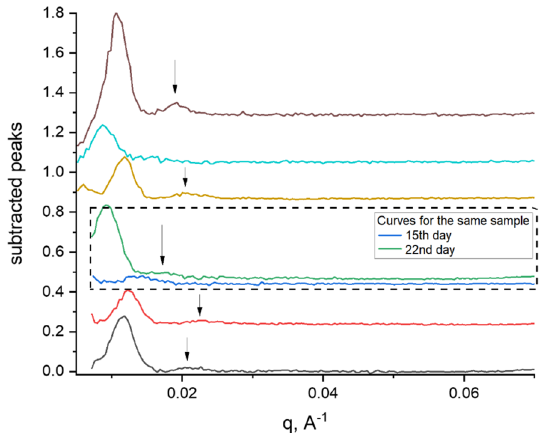
Figure 4. SAXS peaks from the lipid/detergent crystallization phase prior to or at the moment of crystal formation. The peaks’ positions correspond to distances 500–700 Å (these values were calculated from the positions of 1st order peaks). The graphs are presented after baseline subtraction. The observed peaks disappeared several days after they appeared. Each curve is measured in a different capillary. The curves are scaled to separate them vertically for better visualization. The dashed rectangle highlights two consecutive curves of the same sample: these curves show that, with time, peak intensity increases and shifts to smaller angles. The arrows indicate the position of the 2nd order